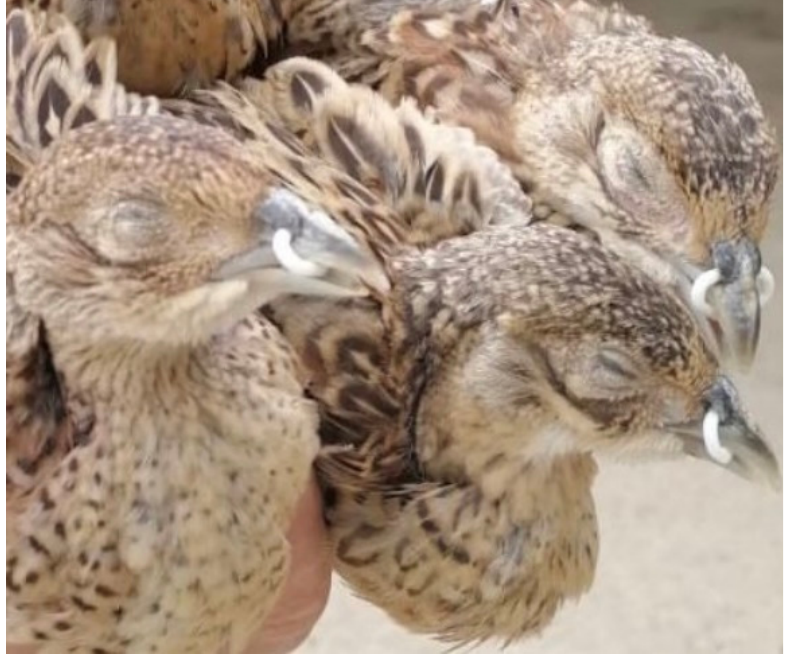
Figure 1. Pheasants aged 6 weeks with clinicals signs of MG infection.